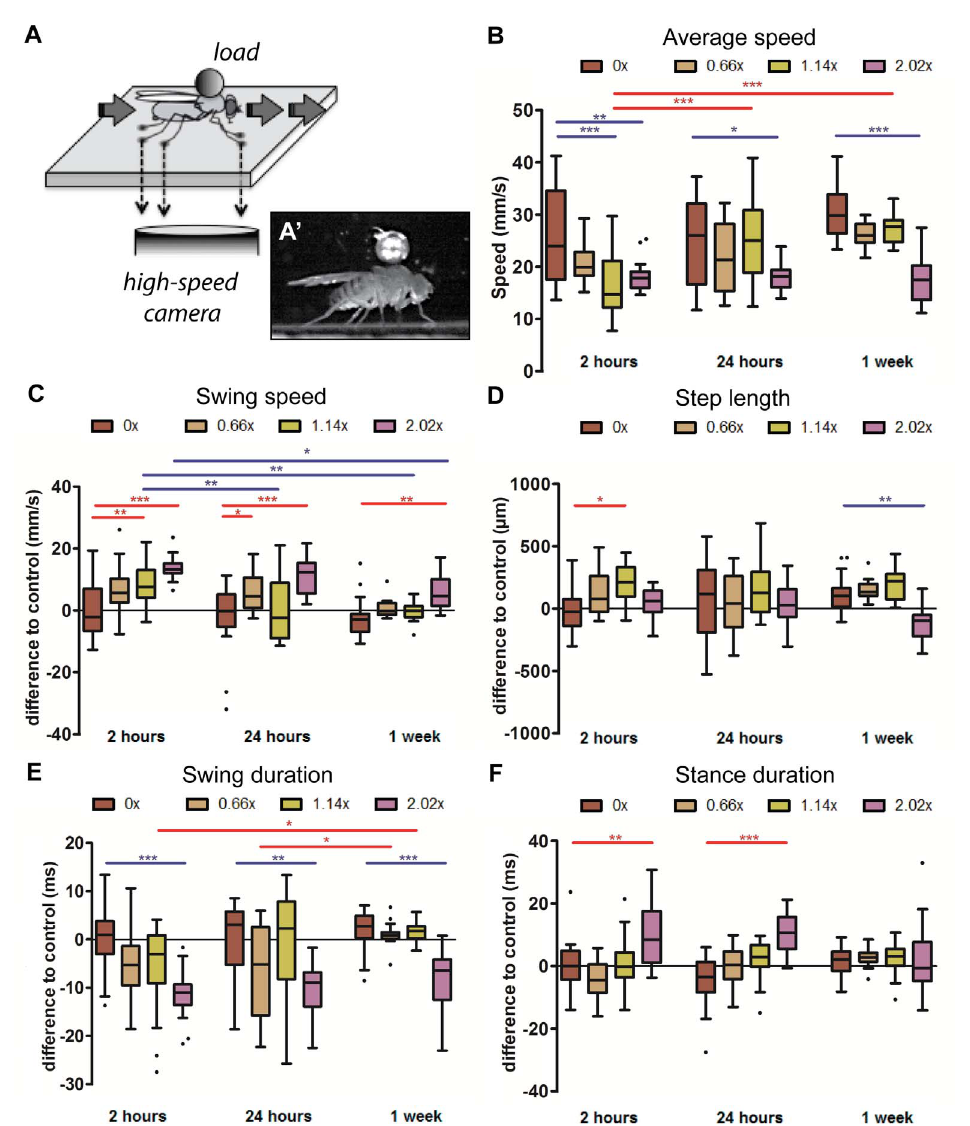
Figure 4. Imaging setup and step parameters. (A) Recording setup. Flies were allowed to walk freely inside a walking chamber on an optical glass with a metal ball bearing attached to the notum. A high-speed camera recorded body and tarsal contacts on the optical glass. (A’) Representative image of a fly carrying a metal ball bearing. (B–F) Box plots represent the median as the middle line, with the lower and upper edges of the boxes representing the 25% and 75% quartiles, respectively; the whiskers represent the range of the full data set, excluding outliers. Circles indicate outliers. Statistical significance was determined using 2-way-ANOVA with post-hoc t-tests, where * p , 0.05; ** p , 0.01; *** p , 0.001. Statistically significant increases or decreases are indicated in red and blue, respectively. (B) Average Speed. Flies bearing 0.66 6 and 1.14 6 show a recovery in average speed by one week, while flies bearing 2.02 6 do not. (C) Swing speed. The immediate effect of weight is an increase in swing speed, although it decreased to that of controls for flies bearing 0.66 6 and 1.14 6 by 1 week. (D) Step length. Step length shows weight-dependence only, where intermediate weights increases step length at 2 hours and the heaviest weight decreases step length at 1 week. (E) Swing duration. Swing duration is significantly decreased for flies bearing 2.02 6 . (F) Stance duration. Stance duration is increased only for the heaviest